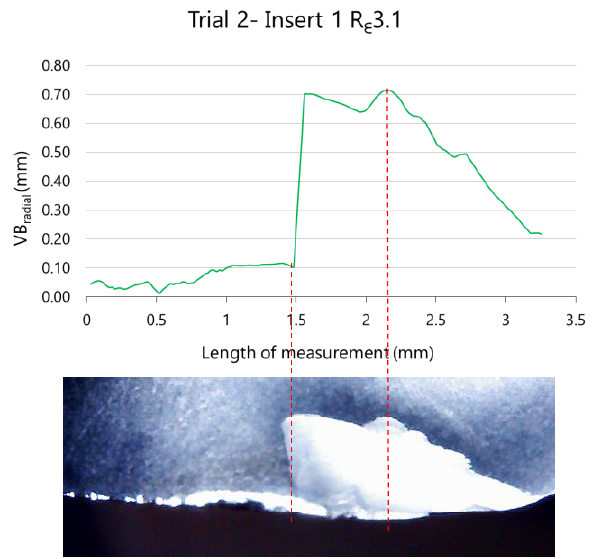
Figure 22. Fracture of insert 1 during trial 2 (removed volume 8.34 × 10 4 mm 3 ) with R ᗴ 3.1 tools.